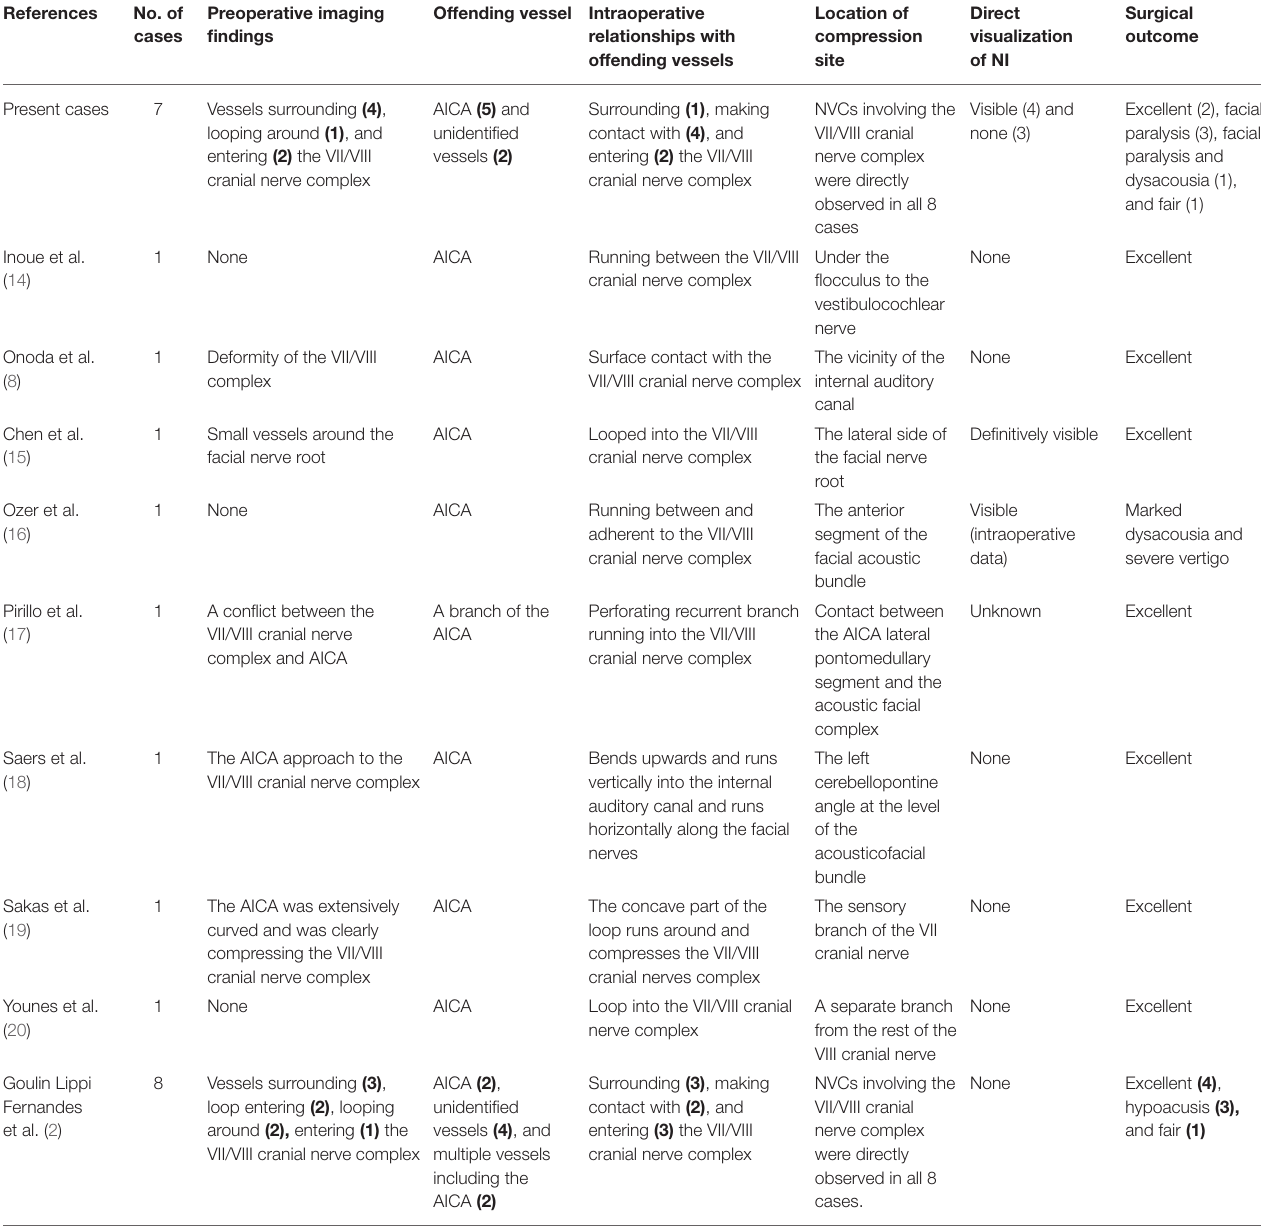
TABLE 2 | Pre- and intraoperative findings in NIN